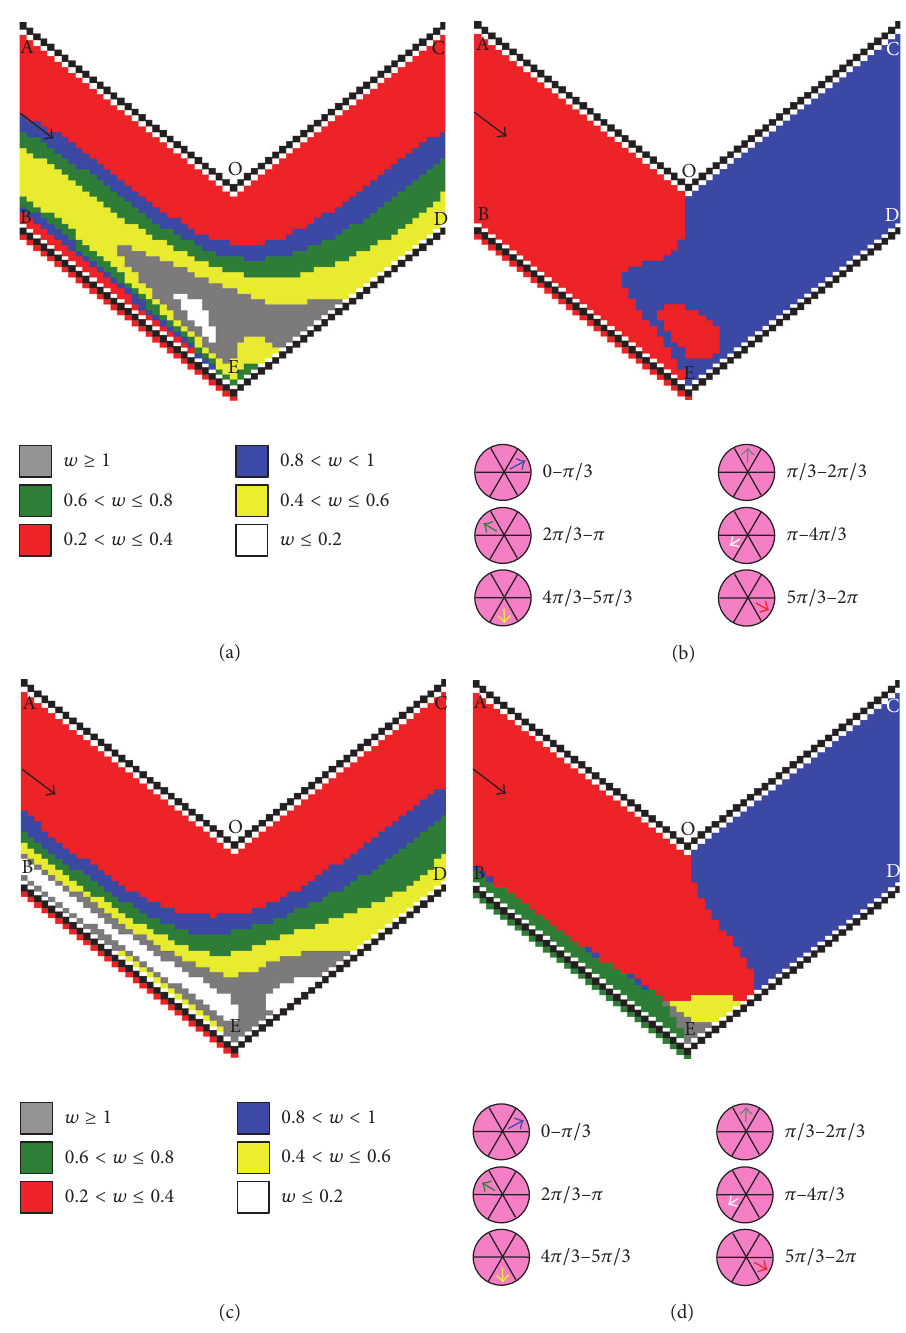
Figure 15: Computational 2D diagrams for the absolute value of dimensionless flow velocity 𝑤 (a, c) and for directions of the vectors of dimensionless flow velocity w (b, d) for the viscous flow of a plasticine workpiece model through obtuse-angled equal channel angular dies AOC–BED of Segal geometry (a, b) with channel intersection angles ∠ (AOC) = 2 𝜃 = 105, where inlet die wall BE moves upstream towards the punching direction with velocity 𝑉 𝑤 = −𝑈 0 (c, d), inlet die wall BE moves downstream stream-wise with increased velocity 𝑉 𝑤 = 2𝑈 0 (a, b), the inlet AB is at the left, and the outlet CD is at the